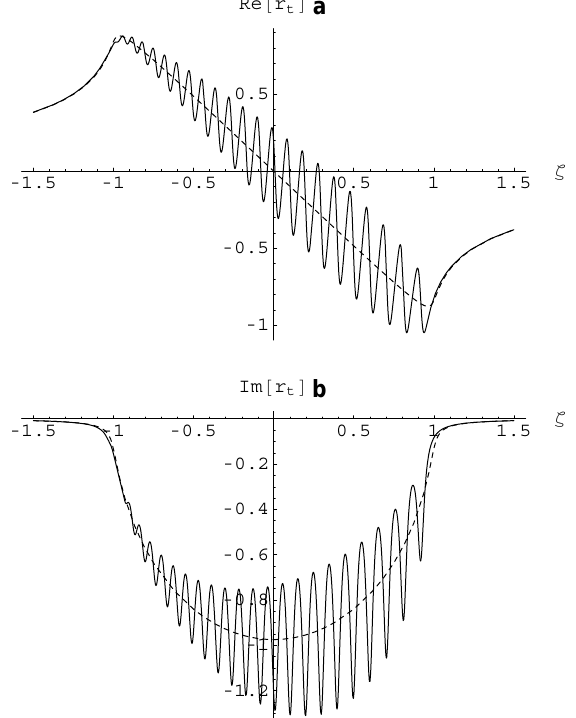
Fig. 9 Fig. 9. Solid curves: The real (a) and imaginary (b) parts of the multiple scatter coupling function r t , with thermal effects included, for the case where p = 1 and (sλ D ) 2 /δ 00 = 0 . 003. The dashed curves are the corresponding cold plasma functions, as in Fig.